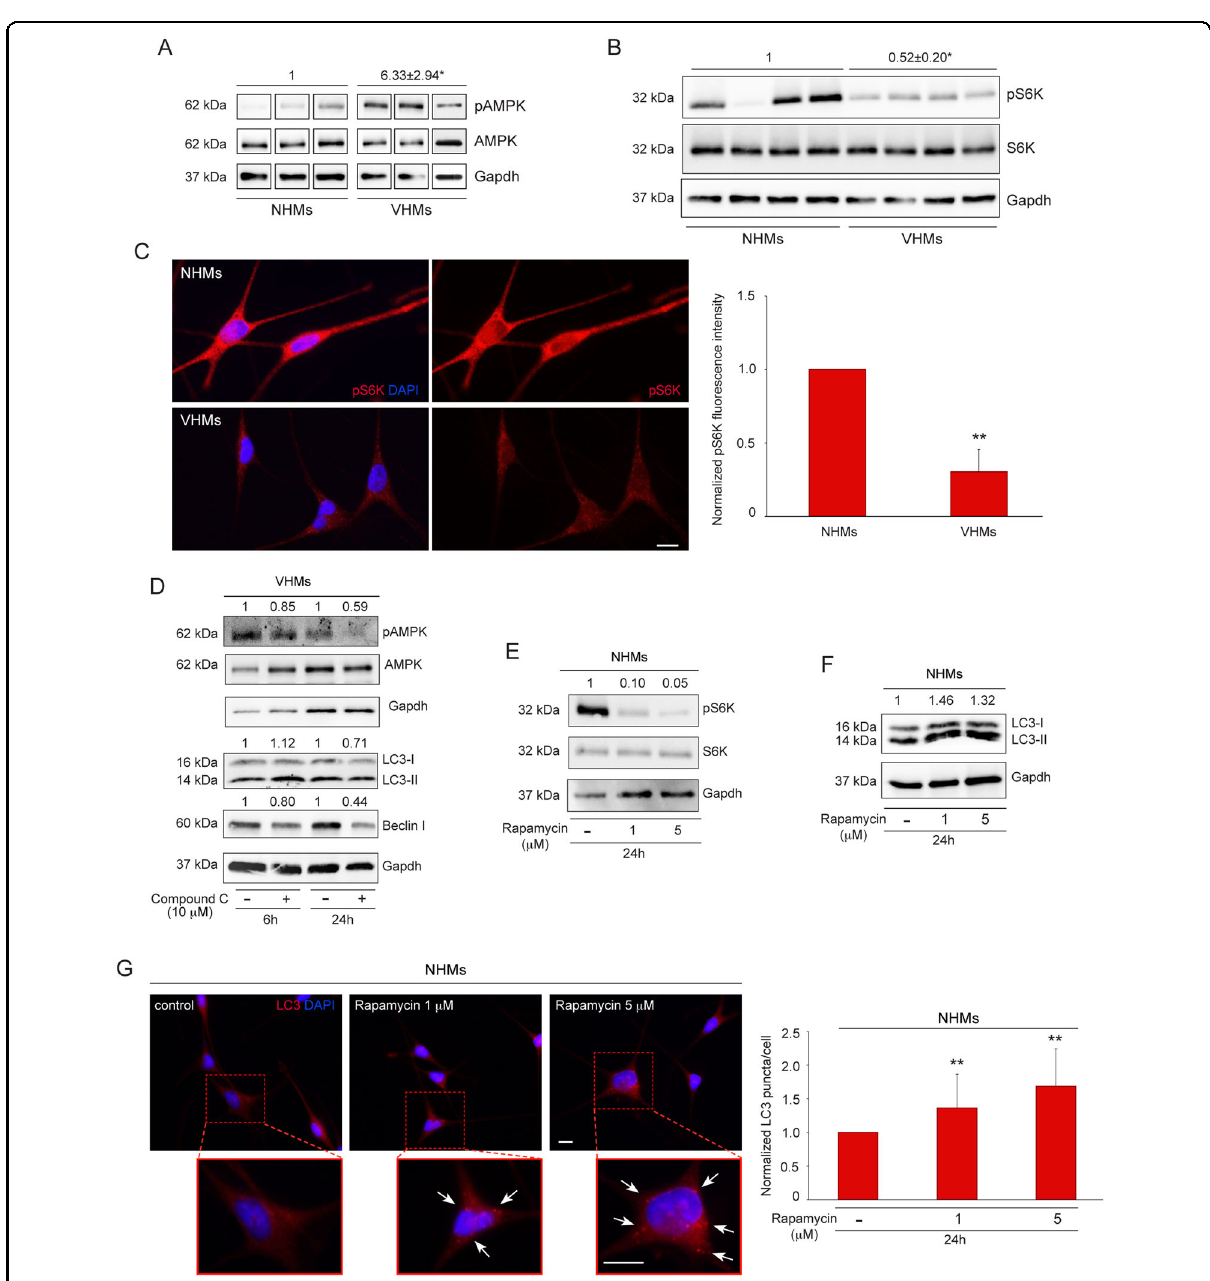
Fig. 2 Metabolic alterations trigger autophagy process through AMPK-mTORC1 signaling. A Western blot and normalized densitometric analysis of pAMPK expression in normal and non-lesional vitiligo melanocytes (NHMs n = 3; VHMs n = 3); B Western blot of pS6K expression with average value of normalized densitometric analyses on cell lysates (NHMs n = 4; VHMs n = 4); C Immuno fl uorescence staining and corresponding normalized fl uorescence intensity for pS6K (red) in normal and vitiligo melanocytes. Nuclei were counterstained with DAPI. A representative normal melanocyte culture paired with a vitiligo melanocyte one is shown. Scale bar: 10 μ m; D Western blot of pAMPK, AMPK, LC3-II/I, and Beclin I with normalized densitometric analysis on vitiligo melanocytes treated or not with Compound C (10 μ M) for 6 and 24 h. Representative blots of three independent experiments are shown; E , F Western blot of pS6K and LC3-II/I expression and corresponding values of normalized densitometric analysis on cell lysates of normal melanocytes after treatment with the mTORC1 inhibitor rapamycin (1 and 5 μ M) for 24 h. A representative blot of three independent experiments is shown; G Immuno fl uorescence staining for LC3 and corresponding quantitative analysis of the number of LC3 positive puncta per cell ( n = at least 150 cells per group) in untreated and rapamycin-treated normal melanocytes for 24 h. Nuclei were counterstained with DAPI. Red boxes show the enlarged view of the selected dashed areas. The arrows point at LC3 positive dots. Scale bars: 10 μ m. A representative normal melanocyte culture is shown. pAMPK, phospho-adenosine monophosphate (AMP)-activated protein kinase; LC3, (microtubule-associated protein 1) light chain 3; NHMs, normal human melanocytes; pS6K, Phospho S6 kinase; VHMs, vitiligo human melanocytes.